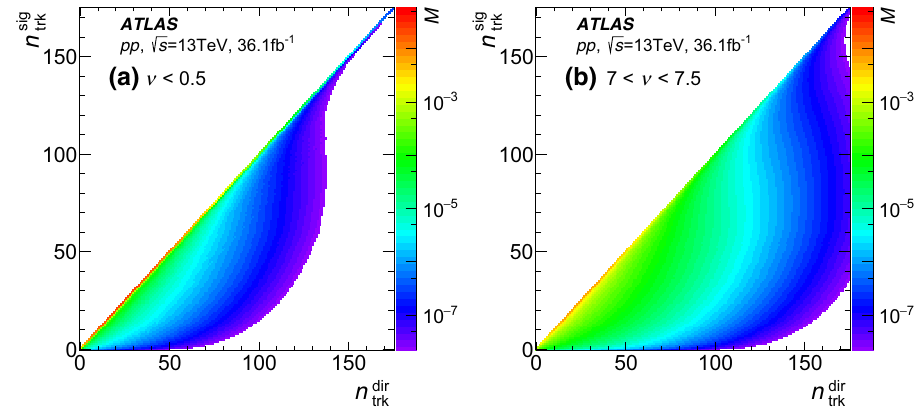
Fig. 6 Data-driven transition matrices corresponding to intervals a ν < 0 . 5 and b 7 < ν < 7 . 5 that are used for remapping Mixed events respectively. The continuous lines are the fits to the data points to smooth the statistical fluctuations at high n trk